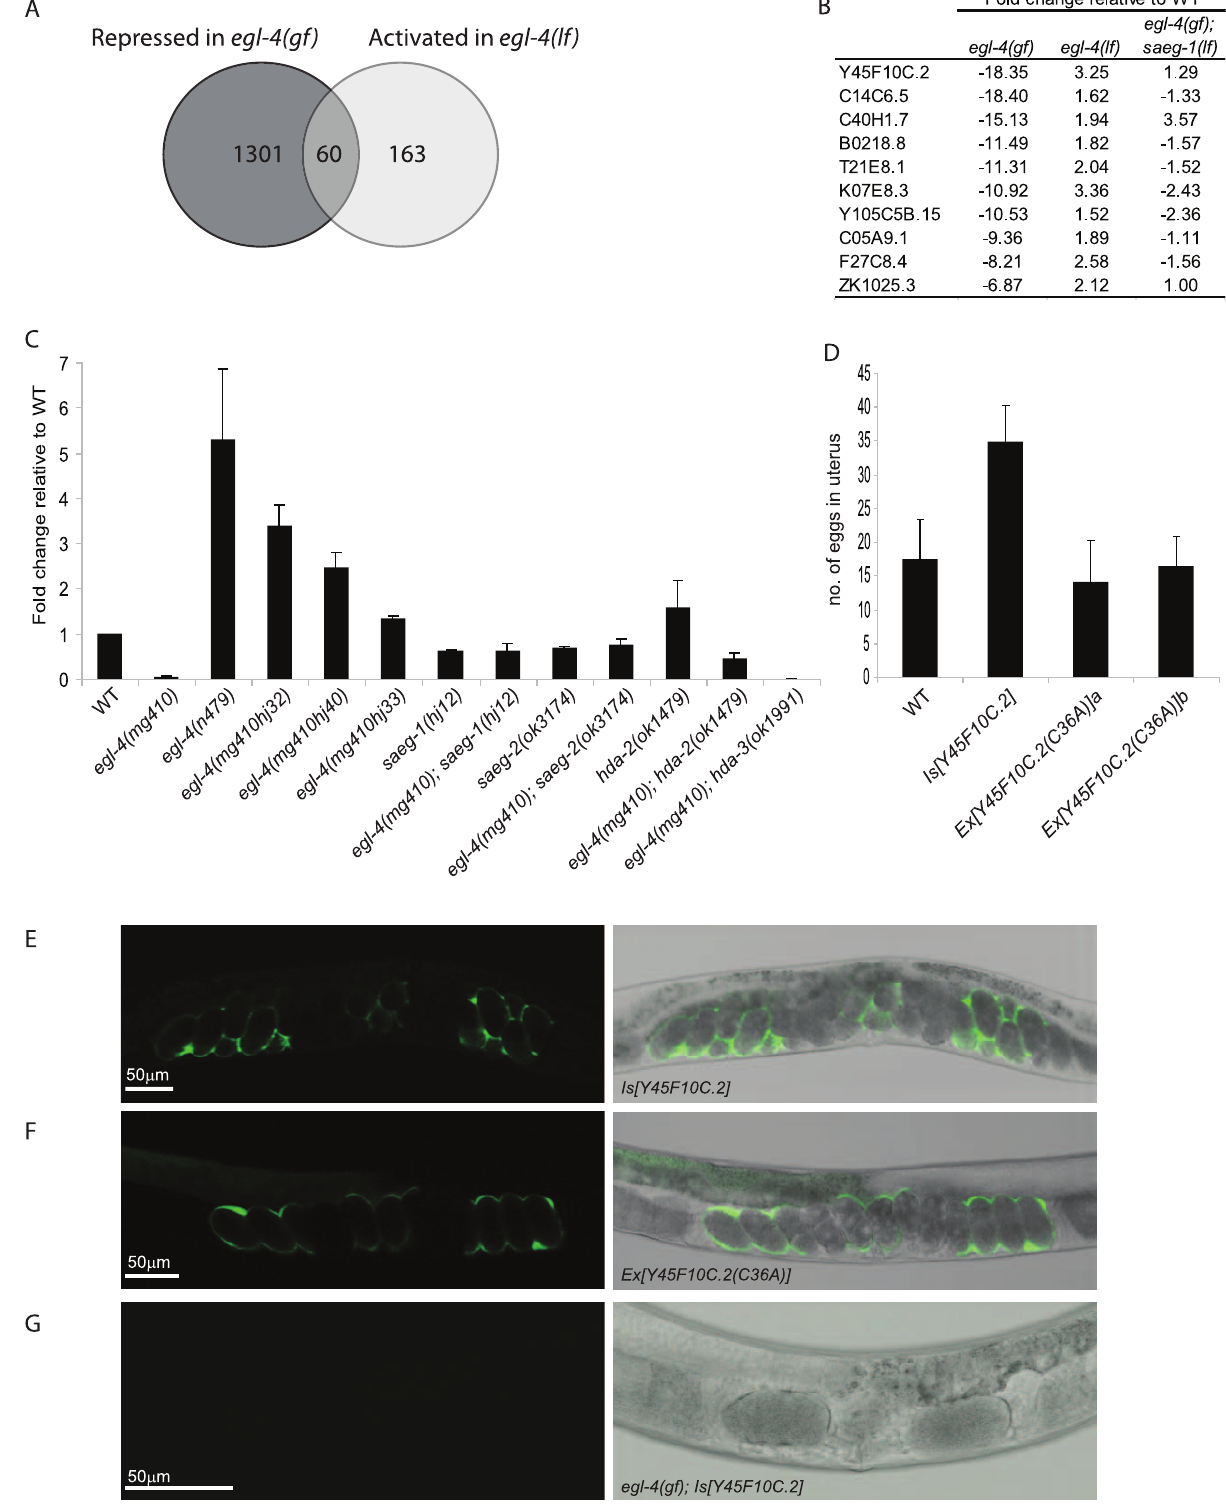
Figure 5. Y45F10C.2 is an EGL-4 activity responsive gene that regulates egg laying. (A) Gene expression profiling using Affymetrix microarray discovered 60 genes that were repressed in egl-4(gf) and activated in egl-4(lf) animals when compared with wild-type animals, using a cut- off of 1.5-fold change, p , 0.05 . (B) Top ten differentially expressed genes in egl-4(gf) versus egl-4(lf) animals. Fold change based on microarray analysis of three independent samples of each genotype is shown. (C) Real-time PCR analysis of Y45F10C.2 gene expression in wild-type and egl-4 mutant animals at young adult stage. At least 2 independent RNA samples were analyzed for each genotype and the expression level in wild-type animals